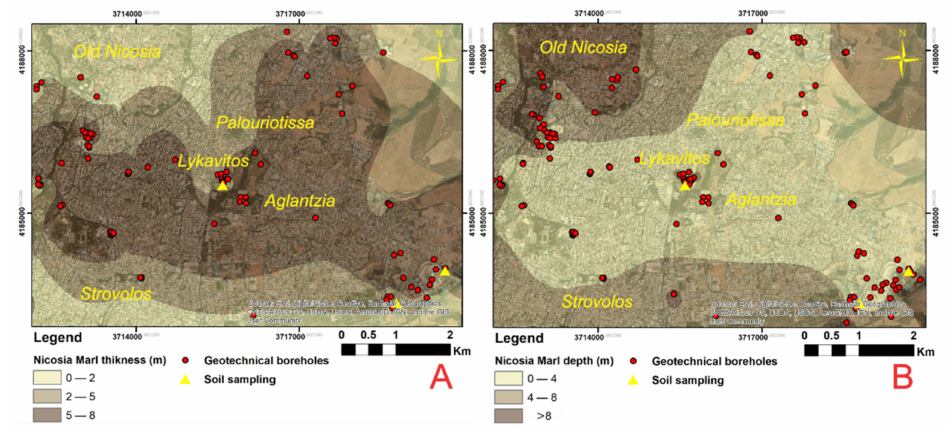
Figure 4. Thematic layers of: ( A ) marl thickness inside active zone and ( B ) upper boundary depth of Nicosia marl in the ground profile.